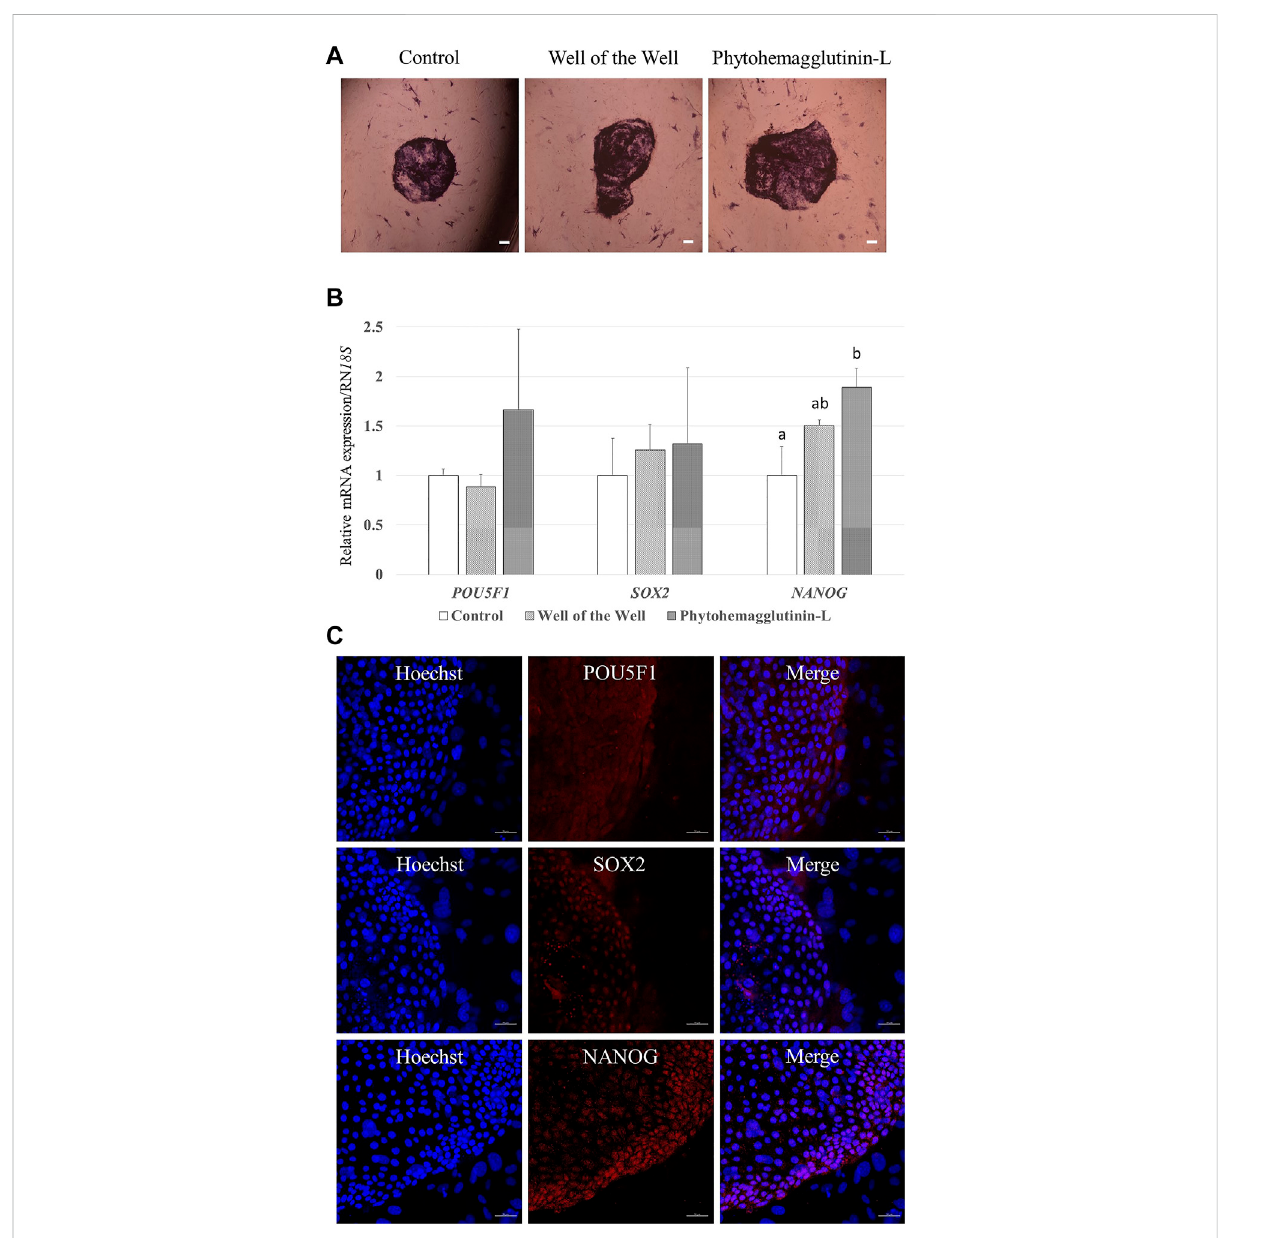
FIGURE 2 Characterization of porcine embryo stem-like cells (pESLCs) from each treatment group. (A) Alkaline phosphatase stain; alkaline phosphatase acts on a substrate to form a purple colored. Scale bar = 200 μ m. (B) Expression of the pluripotency-related genes ( POU5F1 , SOX2 , and NANOG ) in pESLCs from each treatment. A total of four replicates were included. a, b Different superscript letters indicate signi fi cant differences within the columns ( p < 0.05). (C) Expression of pluripotent markers ( POU5F1 , SOX2 , and NANOG ) in pESLCs from phytohemagglutinin-L, as assessed by immuno fl uorescence. Nuclei and pluripotent markers are shown in blue and red, respectively. Scale bar = 50 μ